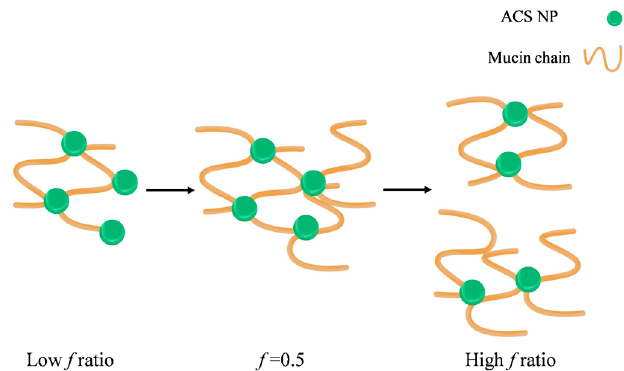
Figure 9. Schematic illustration of the proposed mechanism leading to the observed maximal complex diameter.